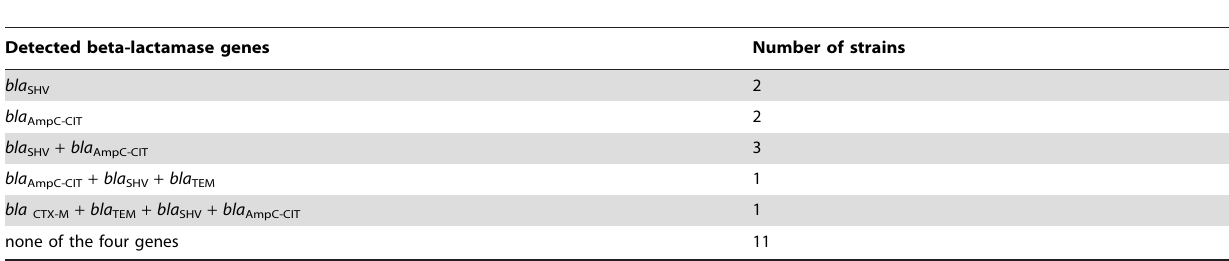
Table 6. Summary of the different beta-lactamase gene combinations occurring among the 20 field isolates.